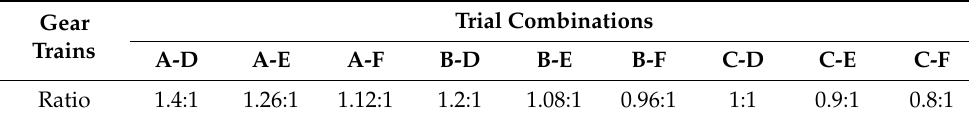
Table 4. Input and output rpm ratio for each of the combinations of links as